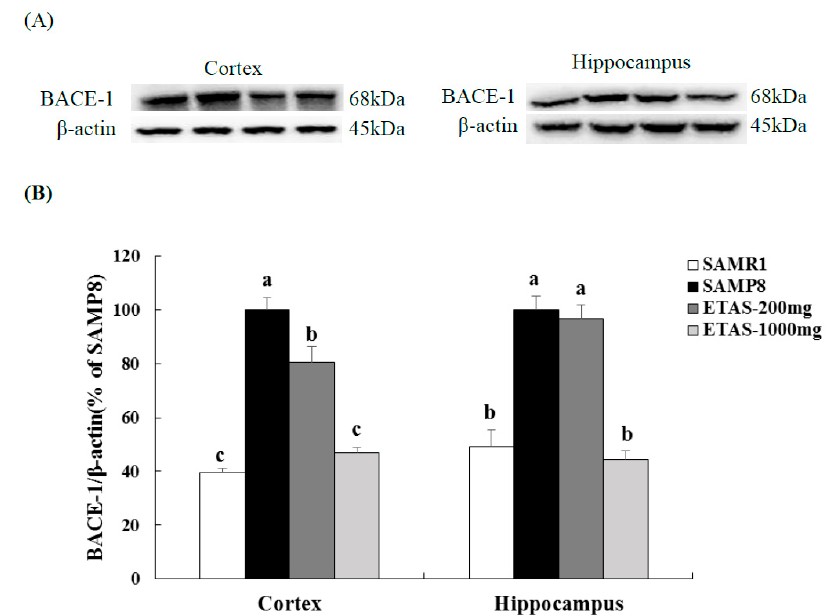
Figure 2. APP expressions in the cortex and hippocampus of 3-month-old male mice fed with a different diet for 12 weeks. ( A ) Electrophoretograms of APP and β -actin expressions. ( B ) APP expressions of different groups. The y axis denotes the percentage of each group compared to SAMP8 control group. Values were mean ± S.E.M. (n = 8/group). Data with different superscripts are significantly different among groups.